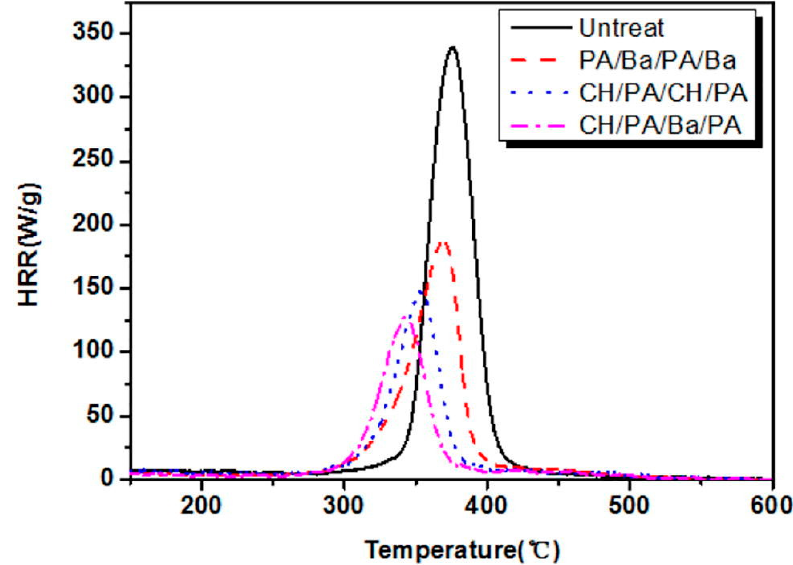
Figure 13. Results from pyrolysis-combustion flow calorimetry tests. PA/Ba/PA/Ba: quad-layer made of phytic acid/Ba 2+ /phytic acid/Ba 2+ ; CH/PA/CH/PA: quad-layer made of chitosan/phytic acid/chitosan/phytic acid; CH/PA/Ba/PA: quad-layer made of chitosan/phytic acid/Ba 2+ /phytic acid. Reprinted with permission from [42]. Copyright 2019, Elsevier.